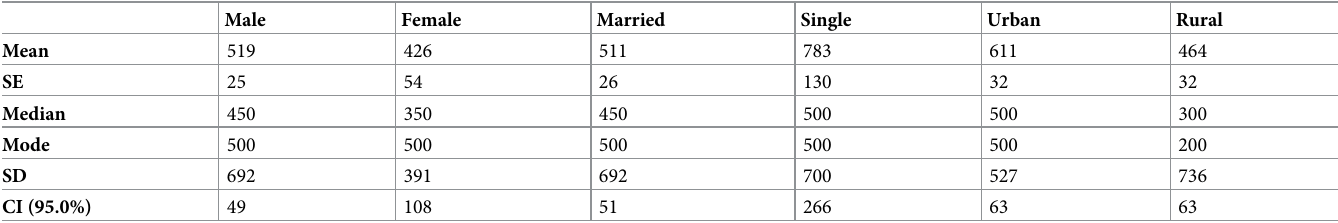
Table 4. Descriptive statistics for amount respondents were willing to